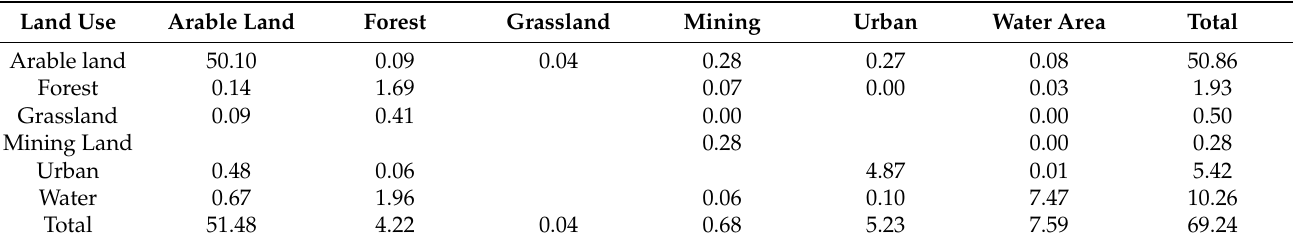
Table 7. Land use transition matrix from pre to post (km 2 ).